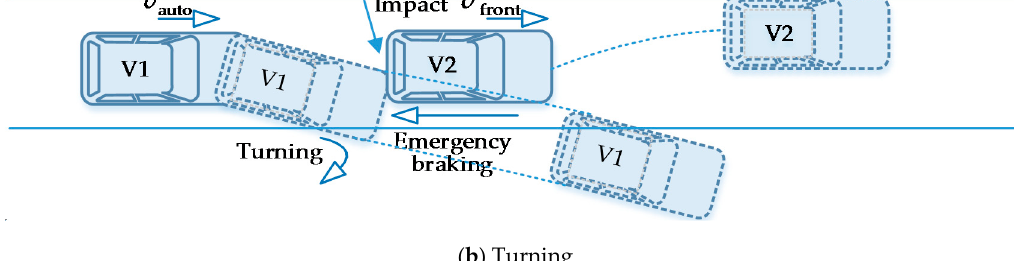
v v refers to the